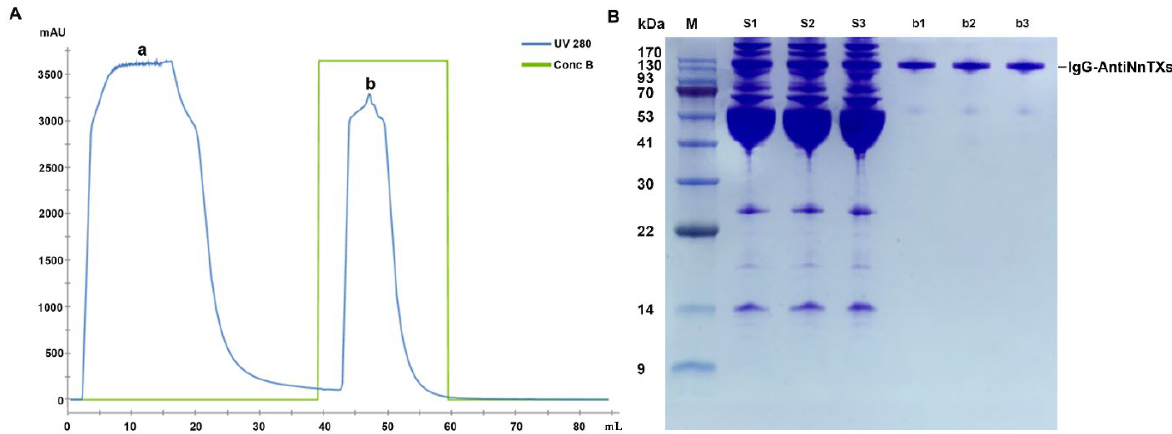
Figure 2. Isolation of IgG-AntiNnTXs from the antiserum. ( A ) Affinity chromatogram of IgG-AntiNnTXs with a protein A column. Peak a: flow through; peak b: IgG-AntiNnTXs containing elution by buffer B (pH = 3.0, 100 mM glycine). ( B ) SDS- PAGE profile of the fractions from the protein A purification. M: protein markers; S1, S2, and S3: antiserum; b1, b2, and b3: fraction of peak b.